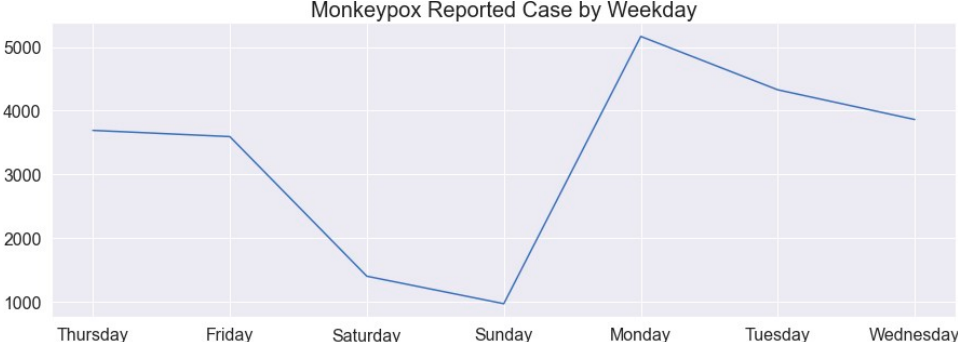
Figure 4. Reported Monkeypox cases by weekday.